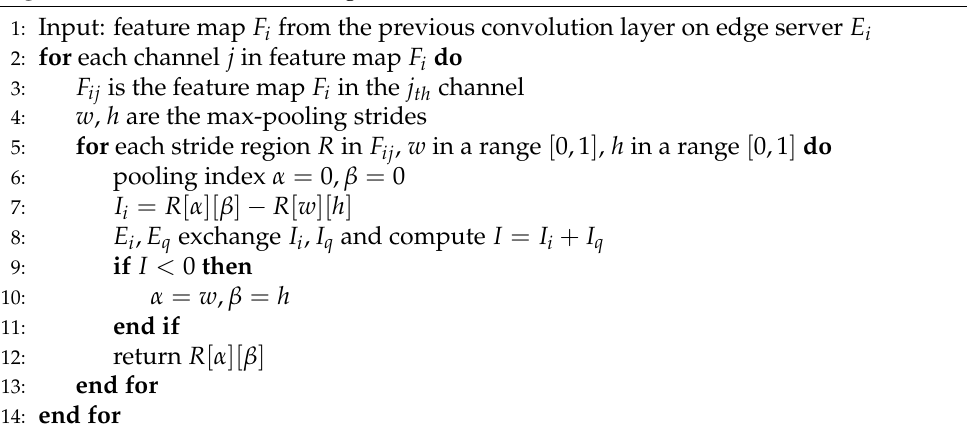
Algorithm 2 Secure Max Pooling